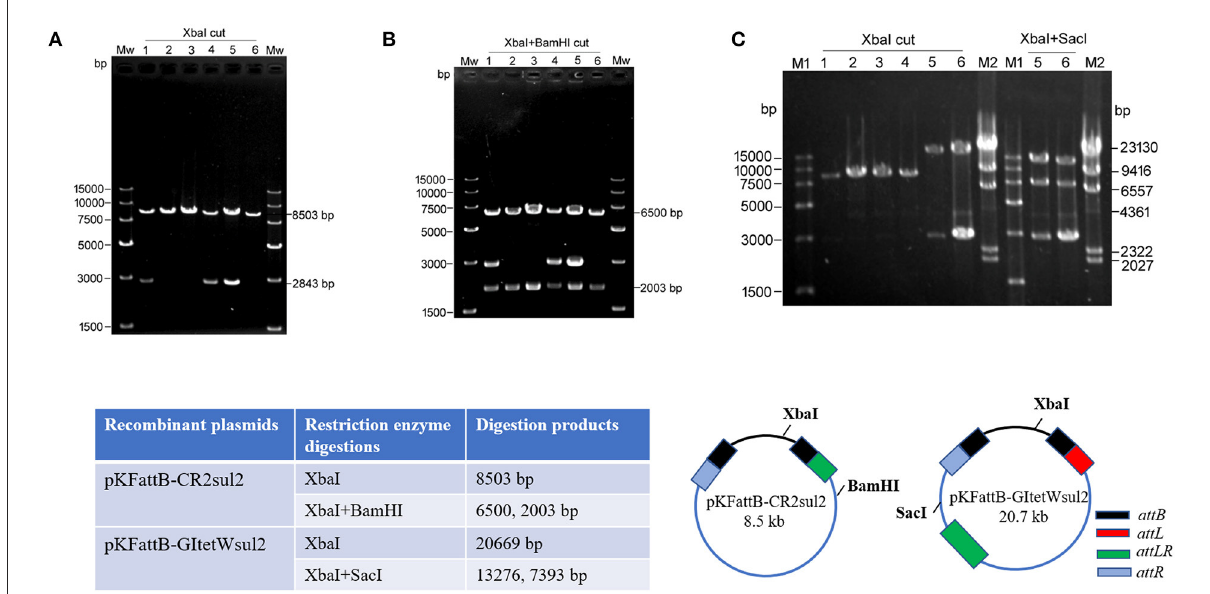
FIGURE5 Integration of circular intermediates into the trap plasmid pKFattB under sucrose negative selection. (A) Xba I digestion of the plasmid extract from six independent recombinant colonies. Bands at 8,503 bp correspond to the recombinant plasmid pKFattB-CR2sul2 (CR2- sul2 inserted into pKFattB) and bands at 2,843 bp correspond to original pKFattB copies. (B) Xba I and Bam HI double restriction of the same plasmid extracts. Bam HI cuts CR2- sul2 unit once and not pKFattB, leading to the digestion of pKFattB-CR2sul2 into 6,500 and 2,003 bp bands. (C) Detection of GItetWsu2-pKFattB structure. Left panel, Xba I digestion of the plasmid extract from six independent recombinant colonies. M1, M2, different DNA markers. Right panel, Xba I and Sac I double restriction of plasmid extracts (number 5 and 6). Sac I cuts GI tetWsu2 once and not pKFattB, leading to the digestion of GItetWsu2-pKFattB into 13,276 and 739 bp bands. The band at 2.8kb is the residual pKFattB plasmid. The bottom schematics exhibit the locus of restriction enzymes and expected digestion sizes for restriction